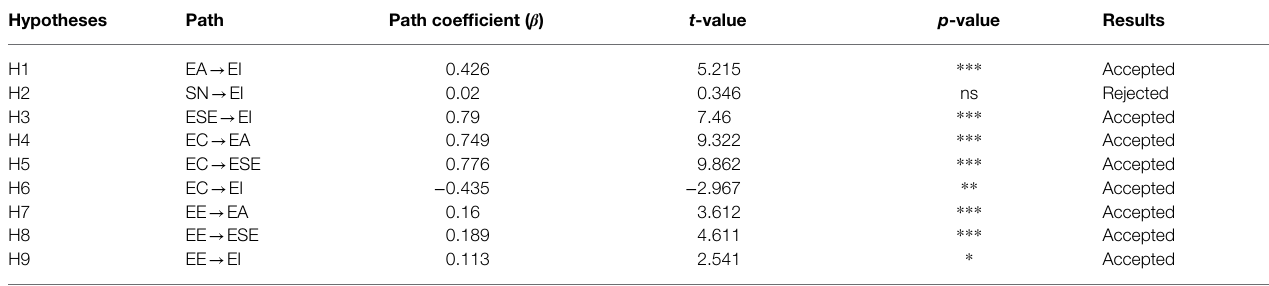
TABLE 6 | Summary of the hypothesis tests.